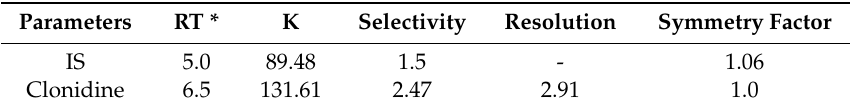
Table 1. System suitability